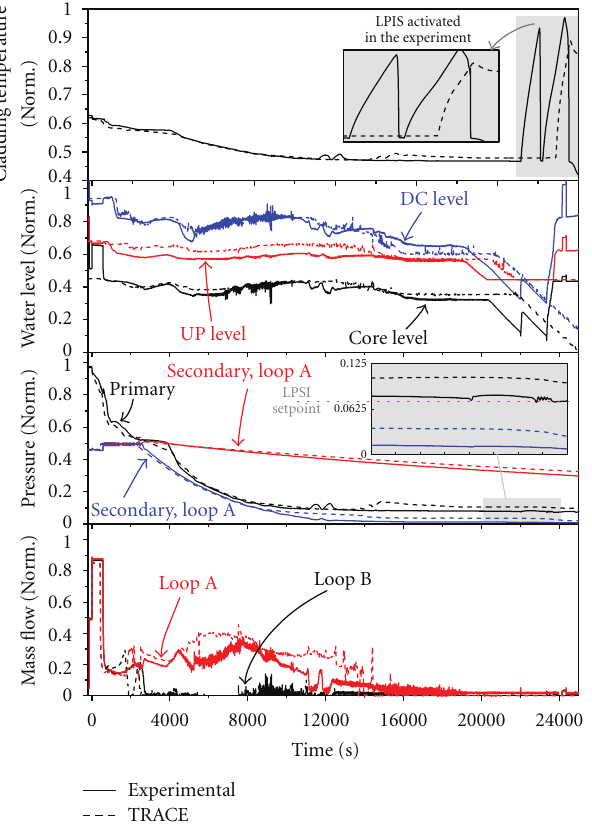
Figure 3: TRACE results for Test 6-2. From top to bottom: (1) clad- ding temperature in position 7 of rod (4,4),(2) RPV water levels, (3) primary and secondary pressures, and (4) loop mass